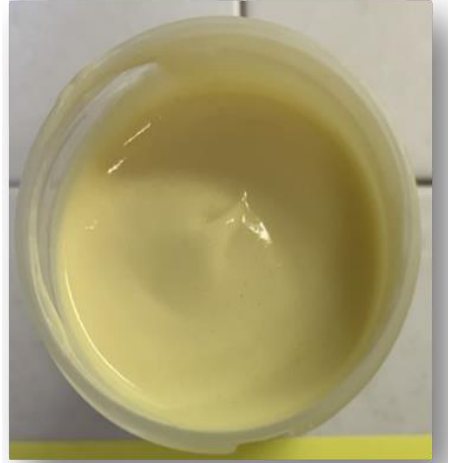
Figure 12. Emulgel loaded with the two flaxseed extracts.